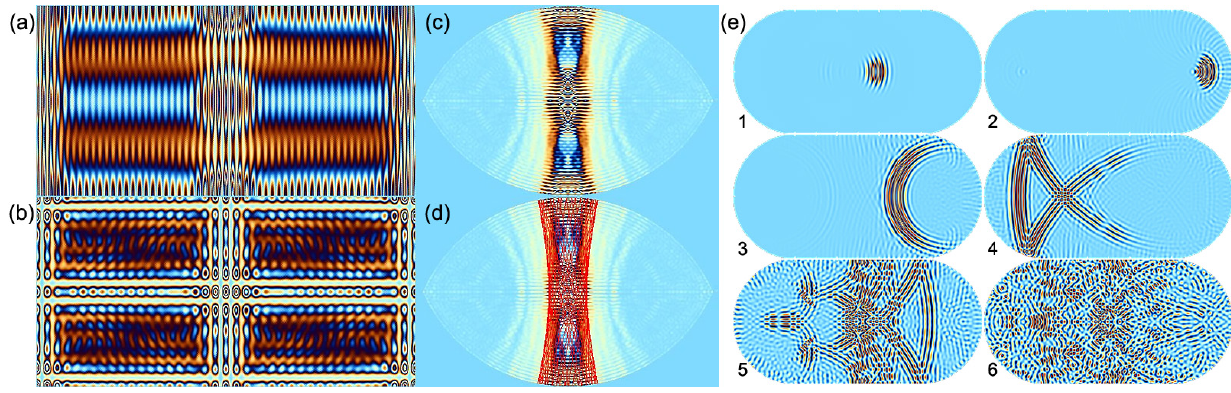
Figure 5: (a, b) The corresponding non-chaotic wave functions for generators a*, b* in Figure 3 in a rectangular potential well do not show scarring, but form regular ordered solutions. (c, d) Non-chaotic wave function corresponding to a quasi-periodic orbit in a lemon-shaped potential well with the quasi-periodic orbit superimposed. (e) The cellular automaton also well models the semi-classical view of the spreading of a traveling wave packet. A small traveling wavelet, generated by clipping sector of a circular ripple with a Gaussian envelope, bounces back and forth, ultimately forming a periodic wave pattern, due to internal resonances generated by its characteristic frequency and wave spreading. Wave spreading compensates for the exponential spreading of the classical repelling orbit and the wave function can form standing wave constructive interference when its energy and consequently its frequency and period corresponds to a fraction of the length of the periodic orbit. Supplement 2: Avi movie of the spreading of the traveling wave